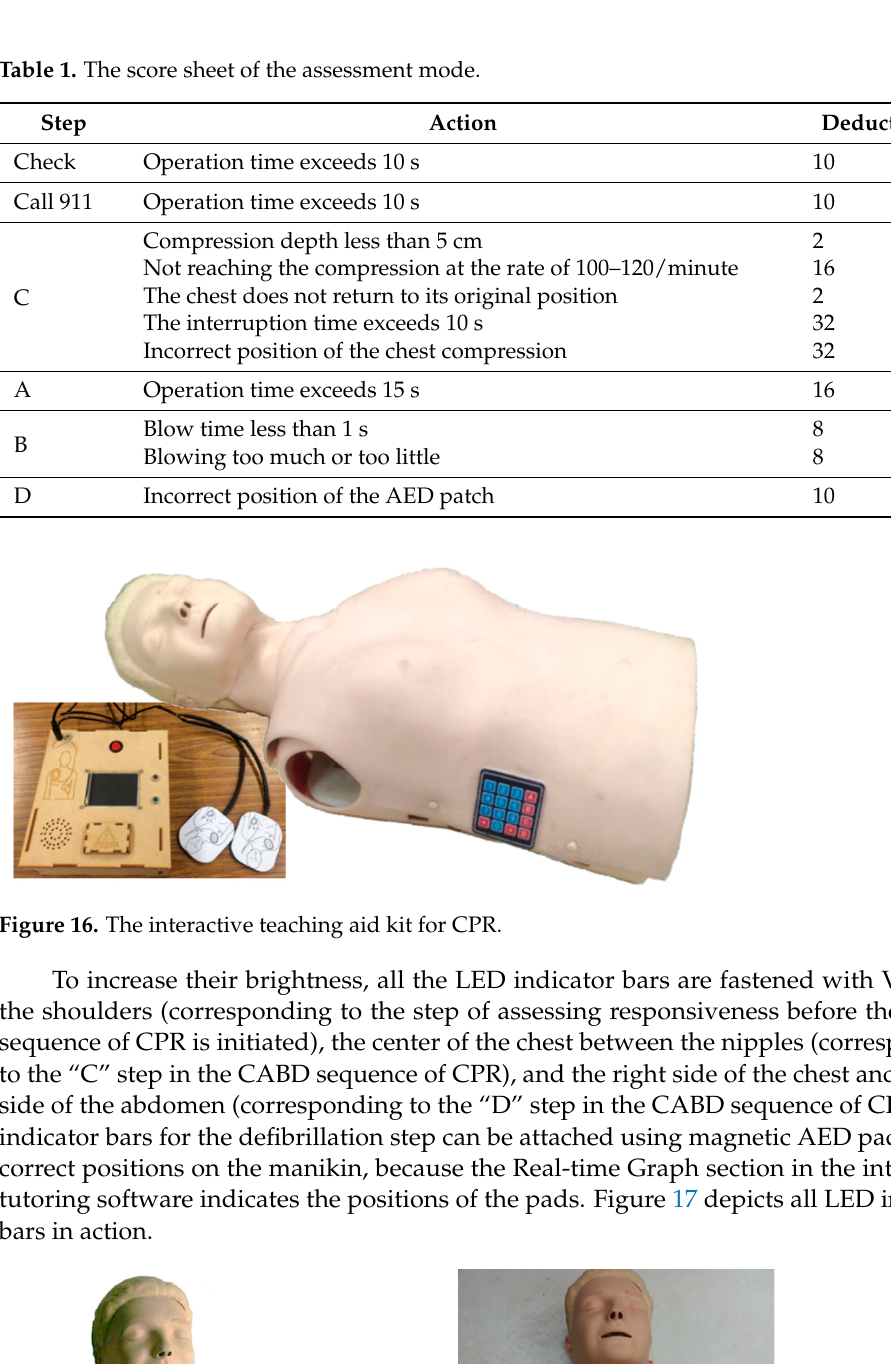
Table 1. The score sheet of the assessment mode.